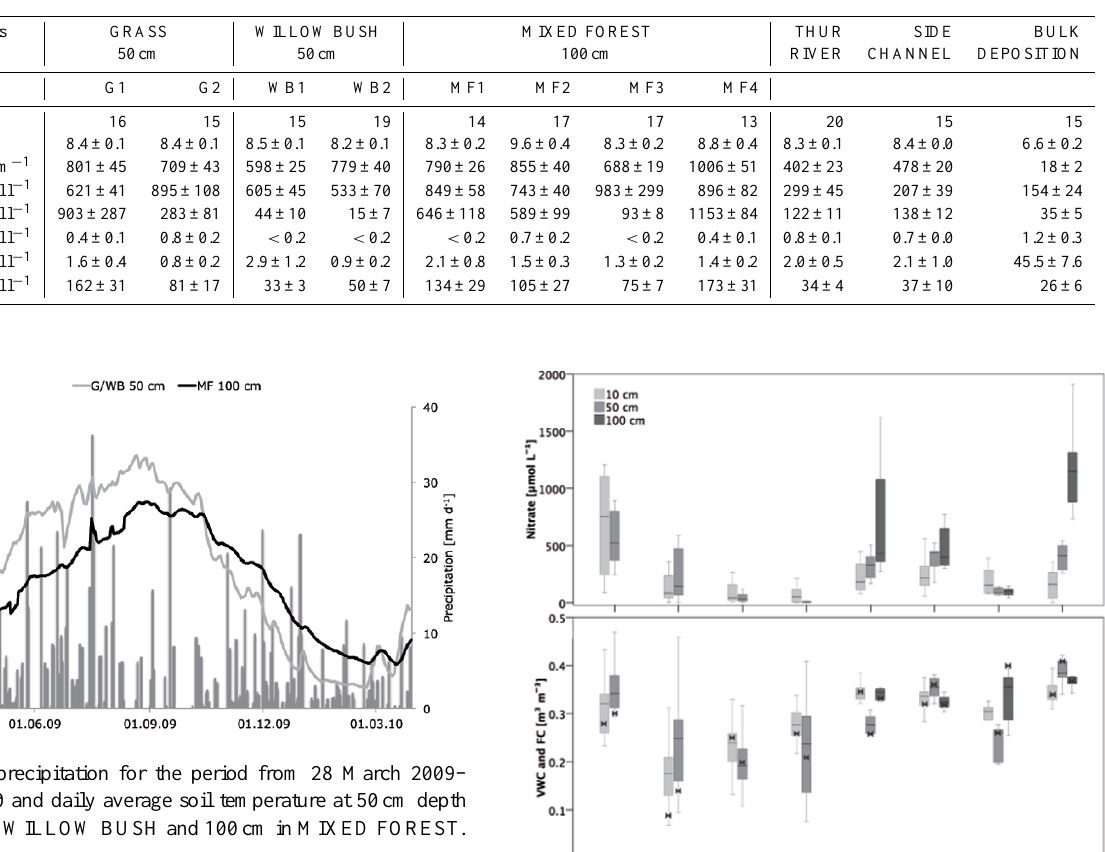
Table 2. Average of chemical constituents (±std error) between 28 March 2009 and 29 March 2010 in soil solutions from the lowest soil compartment in different FPZs, the Thur River, side channel and bulk deposition for n replicates.